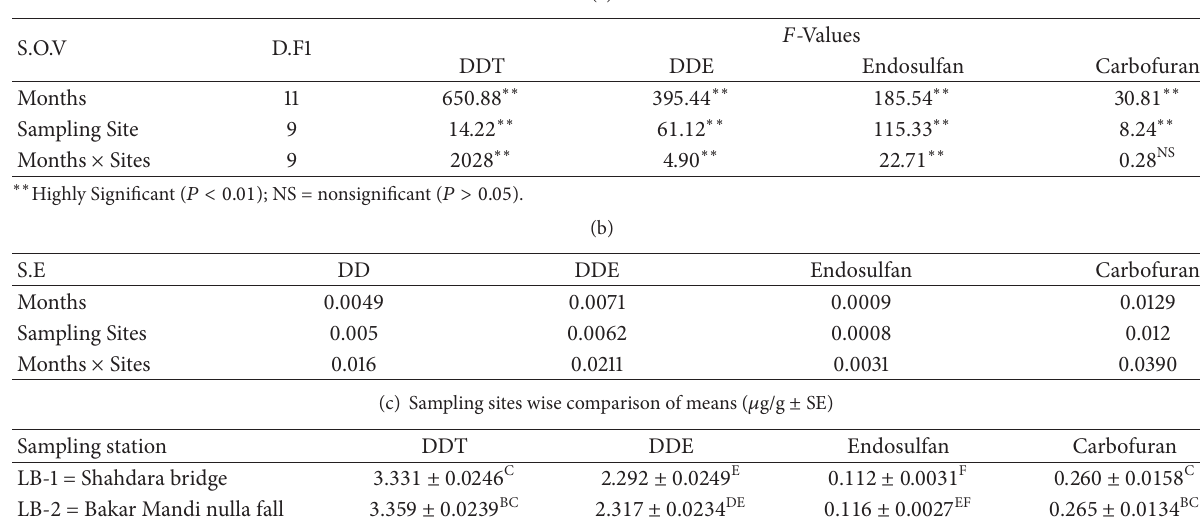
Table 1: Analysis of variance on pesticide concentrations in Catla catla collected from Ravi River from Shahdara to Head